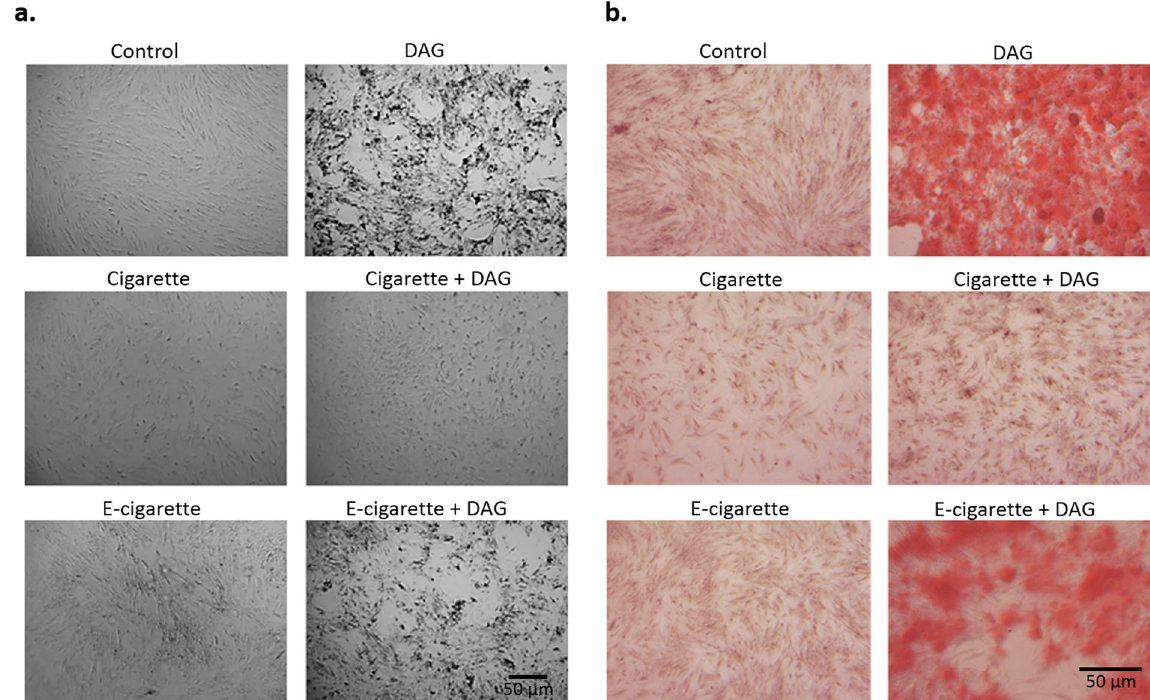
Figure 3. Cigarette and e-cigarette smoke extracts block progress towards terminal osteogenic differentiation. MSCs were treated with cigarette and e-cigarette smoke extracts in the presence or absence of DAG for 21 days. ( a ) Cell morphology was observed under the light microscope. Mineral deposition in the plates is evident as black spots. ( b ) MSCs were stained with Alizarin Red S stain and observed under the light microscope. Orange staining indicates mineralized calcium deposits. Images are representative of 3 independent